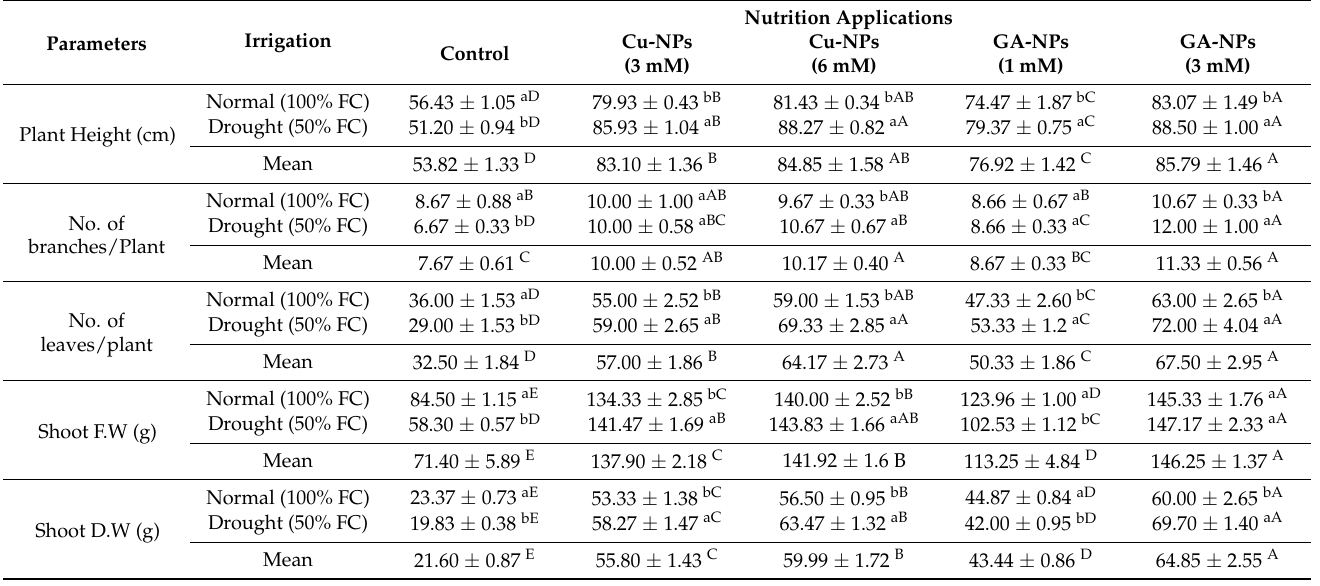
Table 4. Effect of irrigation treatments, Cu-NPs and GA-NPs applications, and its interaction on growth parameters of